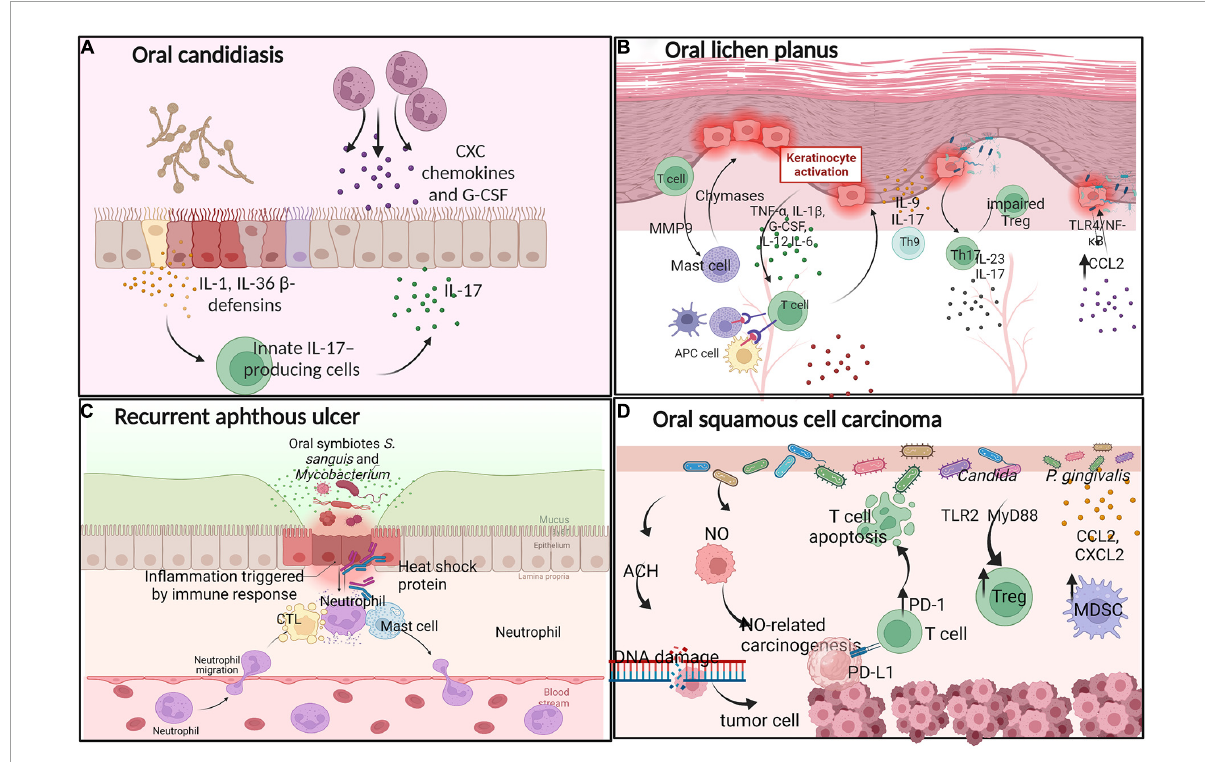
FIGURE2 Interactions between oral microbes and immune cells in oral diseases. (A) Oral candidiasis: C . albicans -induced IL-1, IL-36, and β -defensins activate innate IL-17-producing cells to release CXC chemokines and G-CSF, promoting a neutrophil response. (B) Oral lichen planus: Oral keratinocytes release a multitude of proinflammatory cytokines, providing insights into the pathogenetic mechanism of OLP. (C) Recurrent aphthous ulcer: Driven by CTLs, neutrophils, and mast cells. (D) Oral squamous cell carcinoma: Some oral microbes produce ACH and NO, recruiting Treg and MDSCs to the tumor microenvironment to support oral cancer